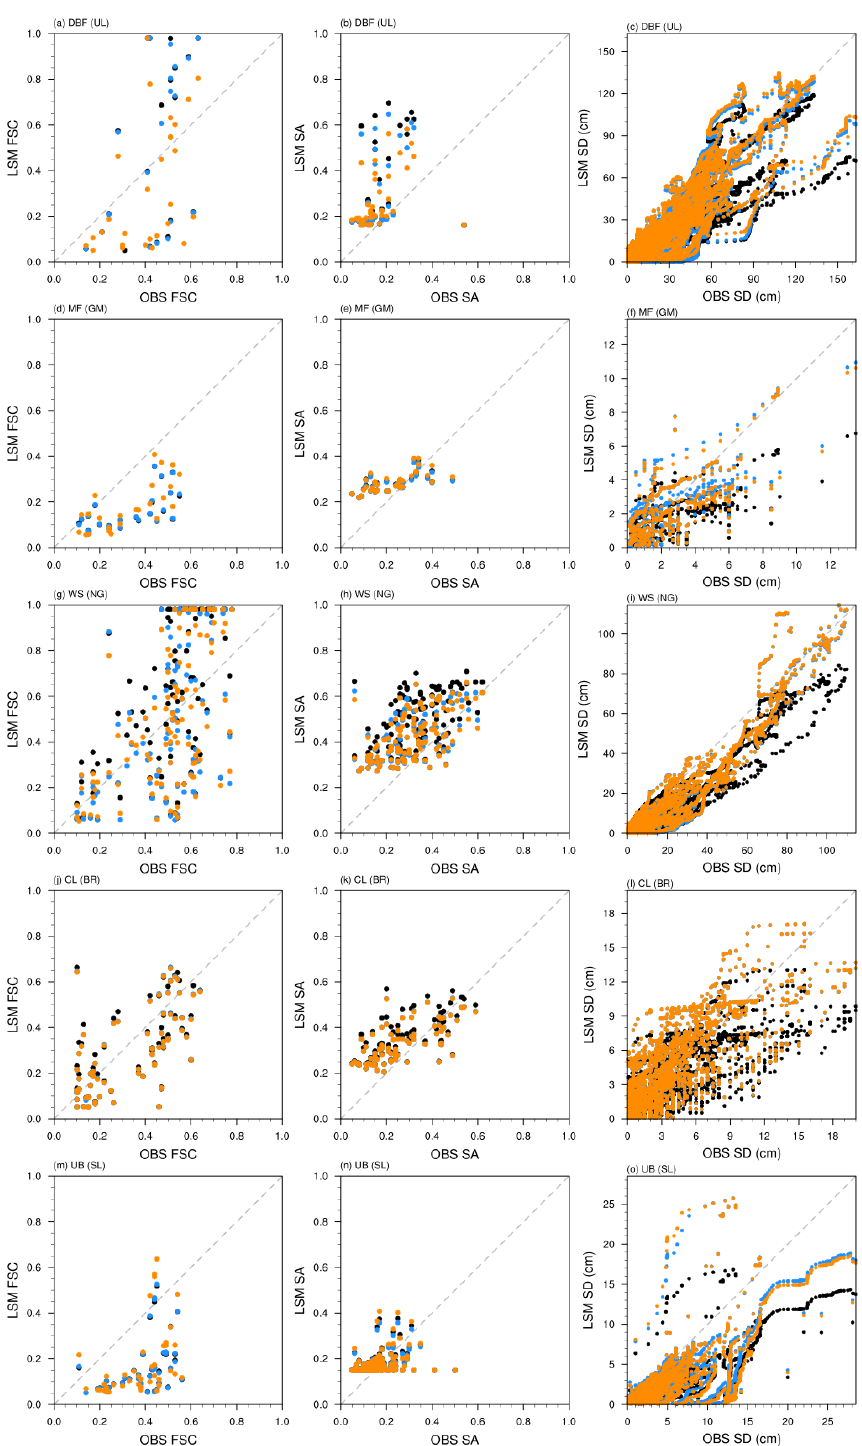
Figure 6. Scatter plots of observations (OBS) and model results (LSM) for snow variables FSC (left panels), SA (middle panels), and SD (cm; right panels) from the verification experiments – CNTL (black dots), VRF_5 (blue dots), and VRF_6 (orange dots), which are evaluated over different LCTs. (a–c) DBF represented by station UL, (d–f) MF by GM, (g–i) WS by NG, (j–l) CL by BR, and (m–o) UB by SL.